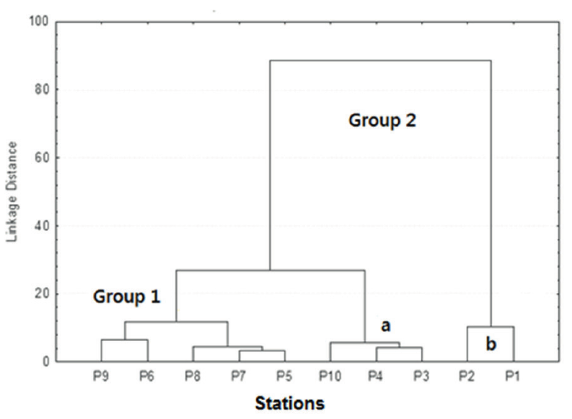
Figure 8 - Total (TP), organic (TOP) and inorganic (TIP) phosphorus (µg.g -1 ) distribution in bottom sediments of the Castanhão Reservoir. Station 1 is the most influenced by the upstream watershed; stations 7 and 10 are located at the dam area. Location of stations as in Figure